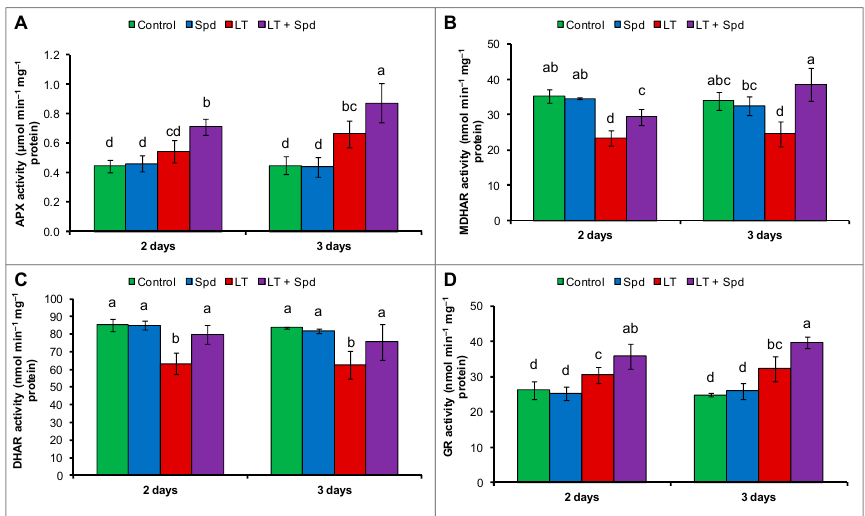
Figure 5. Activities of ascorbate peroxidase (APX) ( A ); monodehydroascorbate reductase (MDHAR) ( B ); dehydroascorbate reductase (DHAR) ( C ) and glutathione reductase (GR) ( D ) in mung bean seedlings. Spd and LT indicate spermidine (0.25 mM) and low temperature (6 °C), respectively. Mean (±SD) was calculated from three replicates for each treatment. Bars with different letters are significantly different at p ≤ 0.05 applying DMRT.